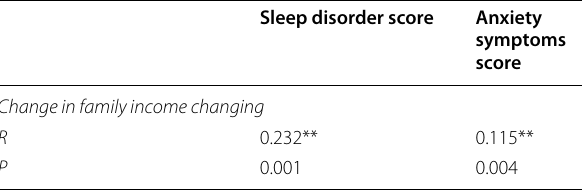
P : Sig. (2-tailed), *correlation is significant at the 0.05 level, **Correlation is significant at the 0.005 level R : Spearman’s rho correlation